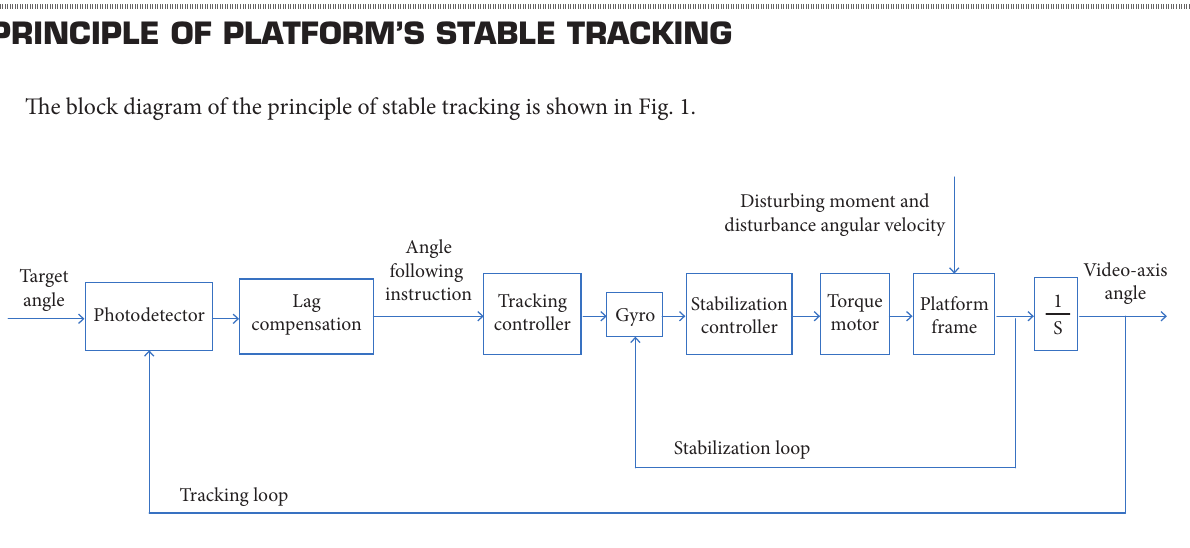
Figure 1. The principle of the platform’s stable